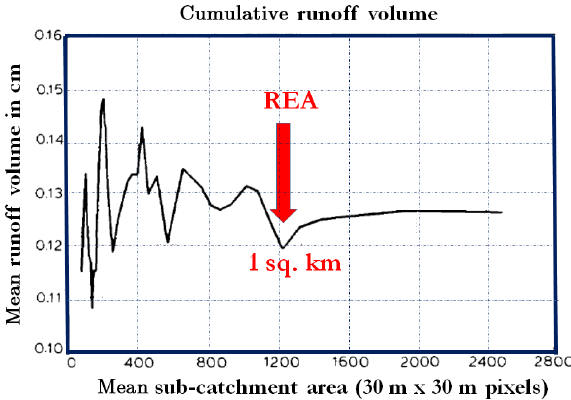
Figure 1. Mean event runoff volume as a function of mean sub- catchment area (for the case of variable topography but uniform soils and precipitation). Adapted from Wood et al.